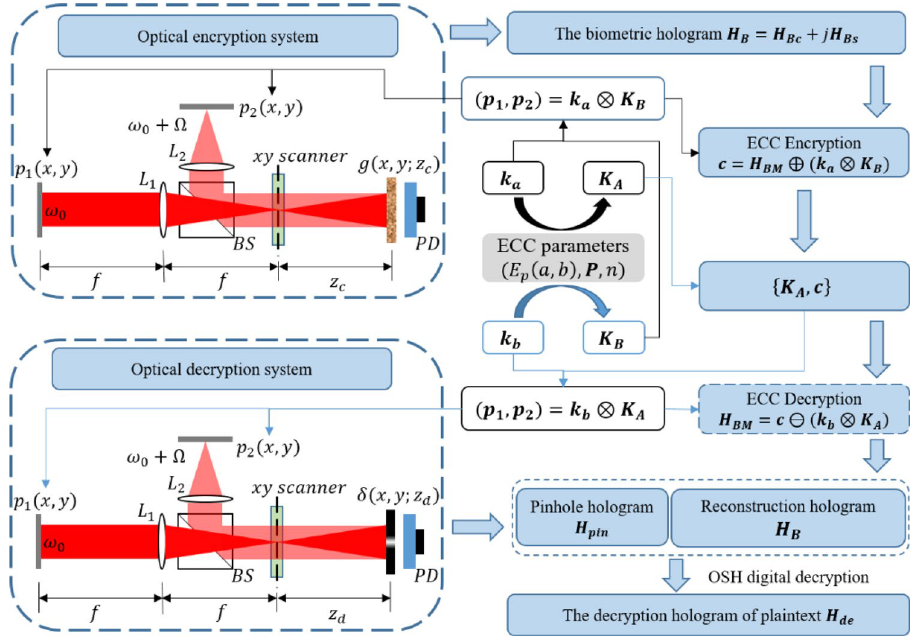
Figure 3. Schematic diagram of the proposed asymmetric